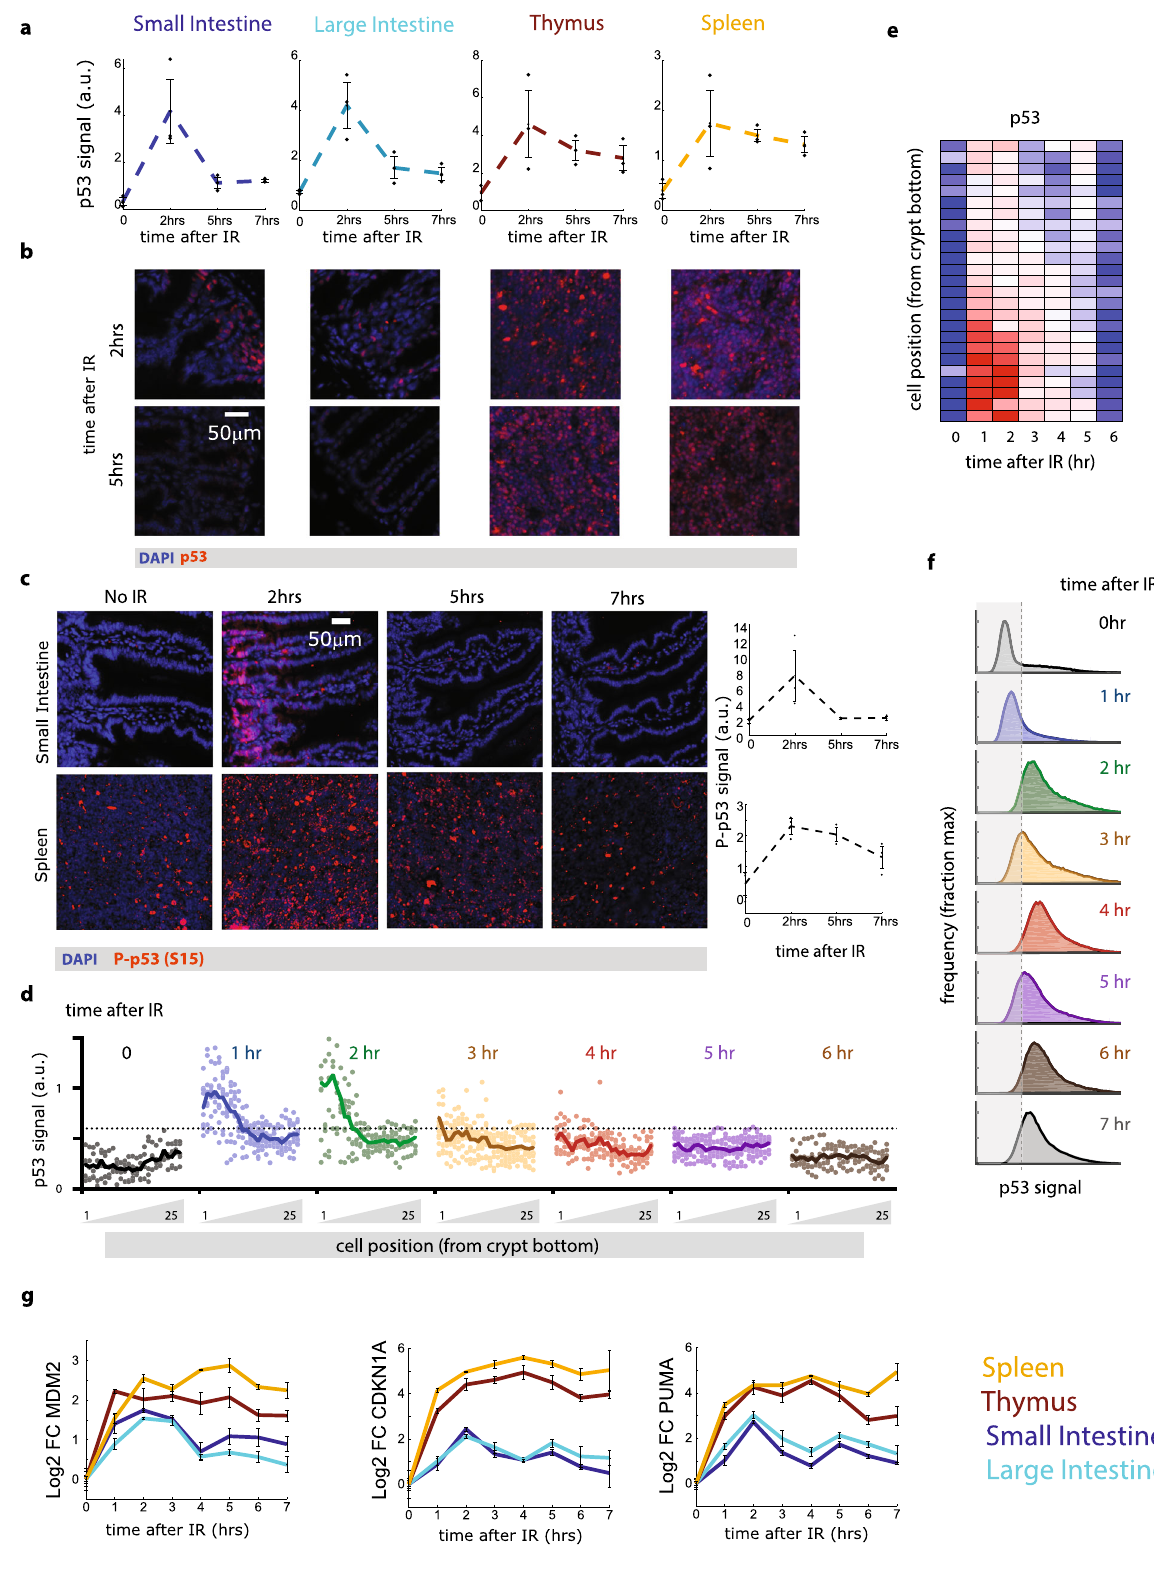
an indolyl-imidazole backbone 28,29 . NMI801 inhibited Mdm2 with a inhibitory concentration of ~1 nM across species, includ- ing human and mouse, as measured in vitro based on the ability of NMI801 to disrupt MDM2-p53 binding (Fig. 3c). Addition of NMI801 to cells in culture with wild-type p53 led to increased abundance of p53 in a dose-dependent manner (Fig. 3d). The